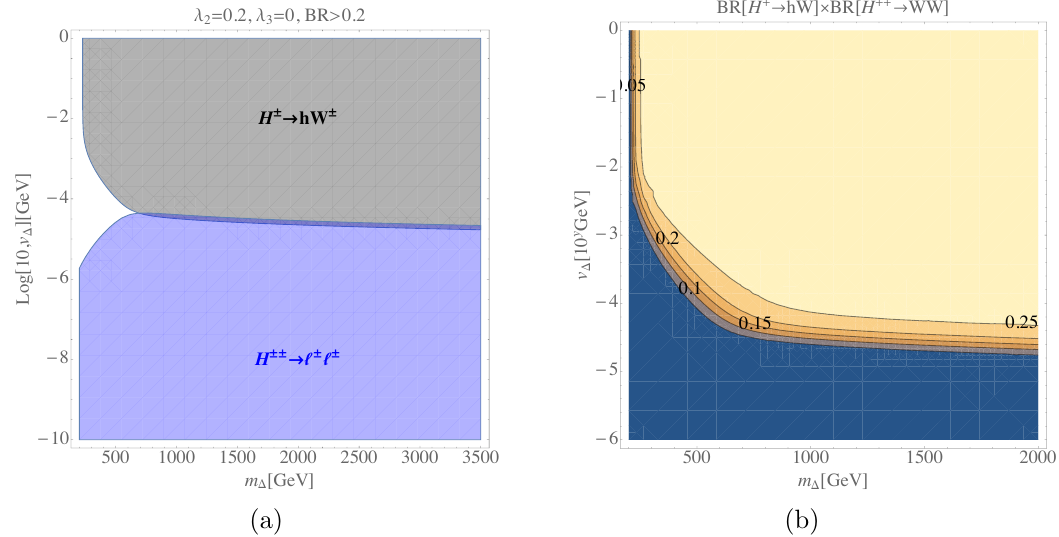
Figure 8 . Decay BRs for (cid:21) 4 = 0, (cid:21) 5 = (cid:0) 0 : 1 and m (cid:23) = 0 : 01 eV. Figure (a): decay BR (cid:21) 20% regions for H (cid:6) ! hW (cid:6) and H (cid:6)(cid:6) ! ‘ (cid:6) ‘ (cid:6) channels. The slowly decreasing BR(H (cid:6)(cid:6) ! ‘ (cid:6) ‘ (cid:6) ) with increasing m (cid:1) explains the \long-tail" of the signi(cid:12)cance plot for H ++ H (cid:0)(cid:0) ! ‘ + ‘ + ‘ 0(cid:0) ‘ 0(cid:0) in (cid:12)gure 7. Figure (b): the solid lines indicate constant contours for BR(H (cid:6) ! hW (cid:6) ) (cid:2) BR(H (cid:7)(cid:7) ! W (cid:7) W (cid:7) ). Product of the BRs is suppressed for small v (cid:1) ’s, which explains feature of the W (cid:6) W (cid:6) hW (cid:7) channel in (cid:12)gure 7 in the small v (cid:1)